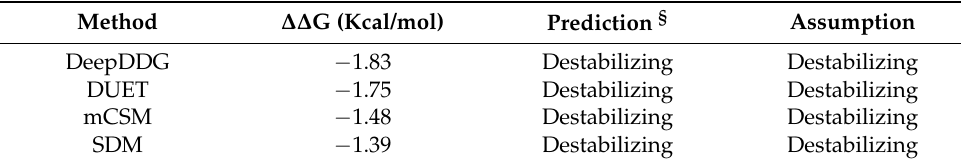
Table 3. Effect of L101F substitution on Mt GidB